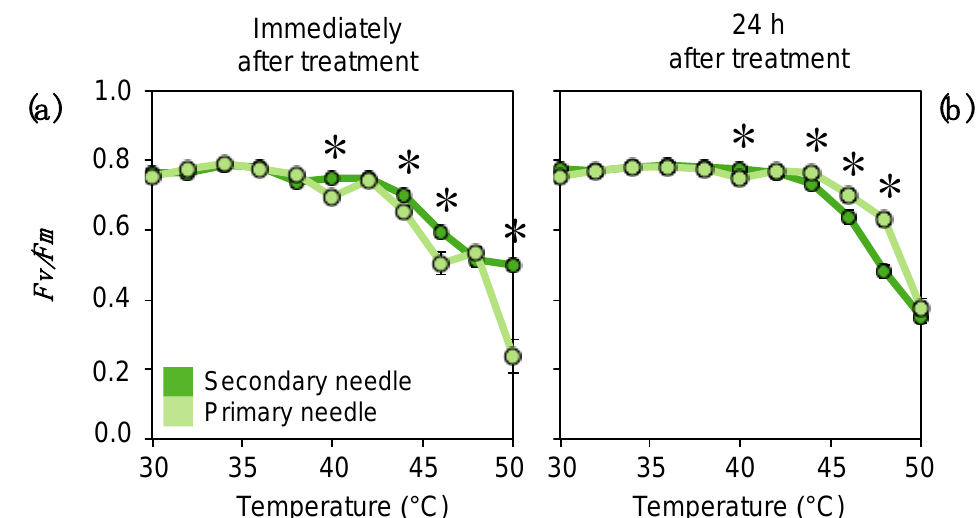
Figure 9. High temperature effects on P. canariensis needles, estimated through values of maximal photochemical efficiency of PSII (Fv/Fm). ( a ) Measured immediately after heat treatments. ( b ) Measurements 24 h after the treatment (needles incubated at +20 ◦ C in darkness). Data are mean ± SE ( n = 5). Asterisks depict significant differences between needle types at certain temperature treatments ( p < 0.05). No statistical differences were found in the absolute water content between needle types used for this experiment: primary needles had 1.43 ± 0.04 gH 2 O g − 1 DW and secondary needles 1.63 ± 0.05 gH 2 O g − 1 DW (mean ± SE, n =